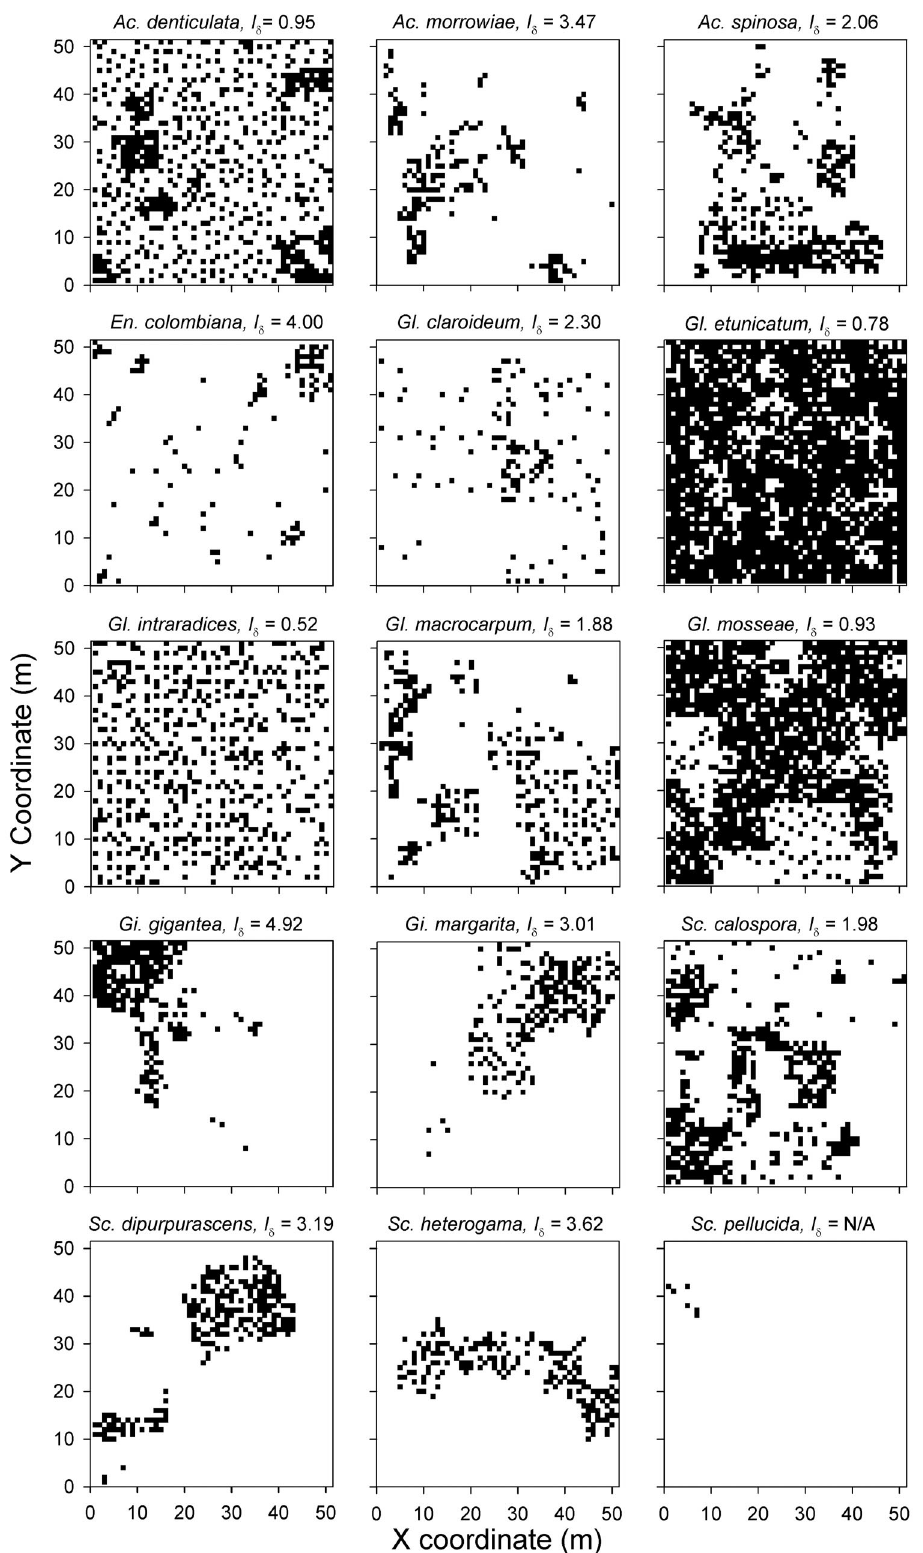
Figure 2. The distribution of each species across the 50 m 6 50 m sampling grid. Species were scored as present or absent in each of the 2601 sampled communities.